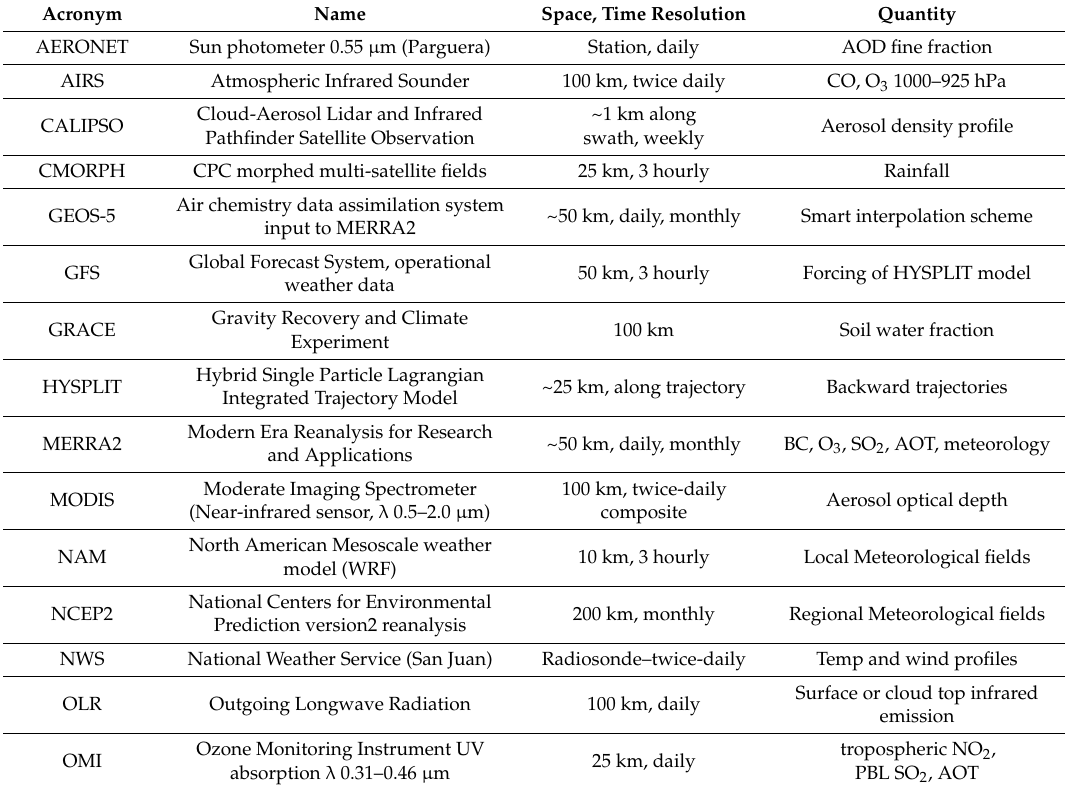
Table 2. Datasets used in the